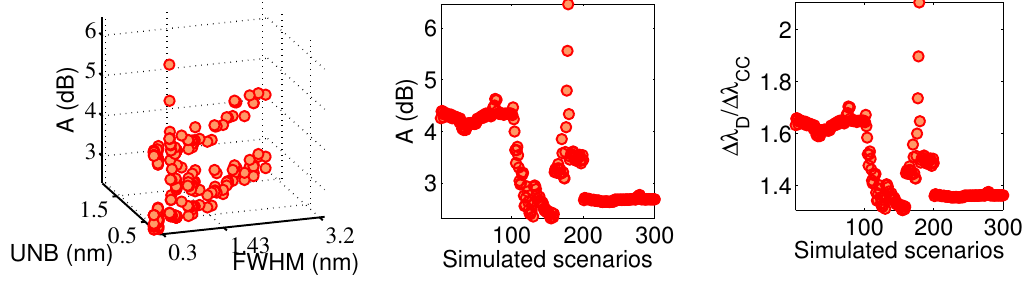
as a function of the simulated ∆ λ CC